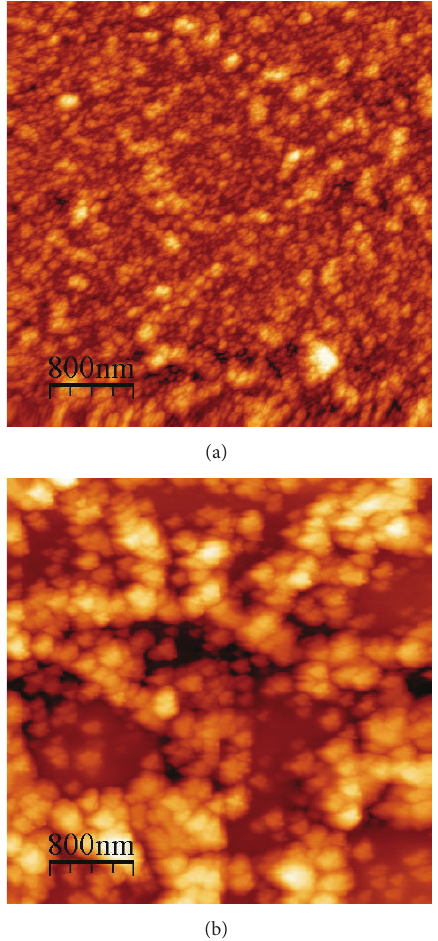
F 9: AFM Images of (a) TTR free and (b) TTR + Pentobarbital 7.68mM